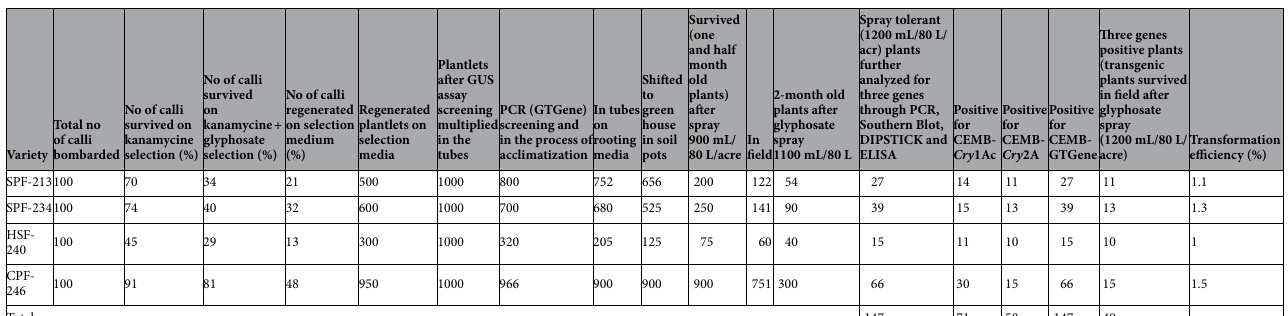
Figure 3. Schematic presentation of all the steps involved in genetic modification of sugarcane. ( A ) Callus for Bombardment. ( B ) Homemade Biolistic machine. ( C ) Bombarded Callus after bombardment with DNA-coated tungsten particles. ( D ) Bombarded callus shifted on selection media with Kanamycime (50 mg/L) after 2 days. ( E , F ) Transformed callus regenerated on double selection (Kanamycine 50 mg/L + Glyphosate 40 mM) media, ( G , H ) Regenerated sugarcane plantlets on glyphosate selection media (45 mM), shifting on shoot multiplication media with Kanamycime (50 mg/L) and glyphosate (50 mM) selections. ( I ) Gus Assay for transgenic plant screening (abcd). ( J ) Transgenic plants for rooting. ( K ) Shifting on rooting media without any selection drug. ( L , M ) Acclimatization: Transgenic sugarcane plantlets in soil pots under green house conditions.